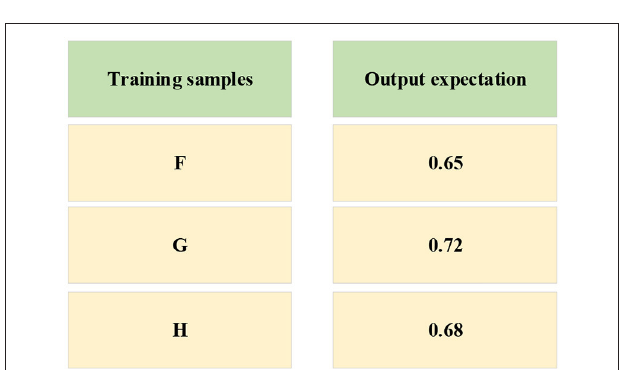
FIGURE 7 | The output value of training